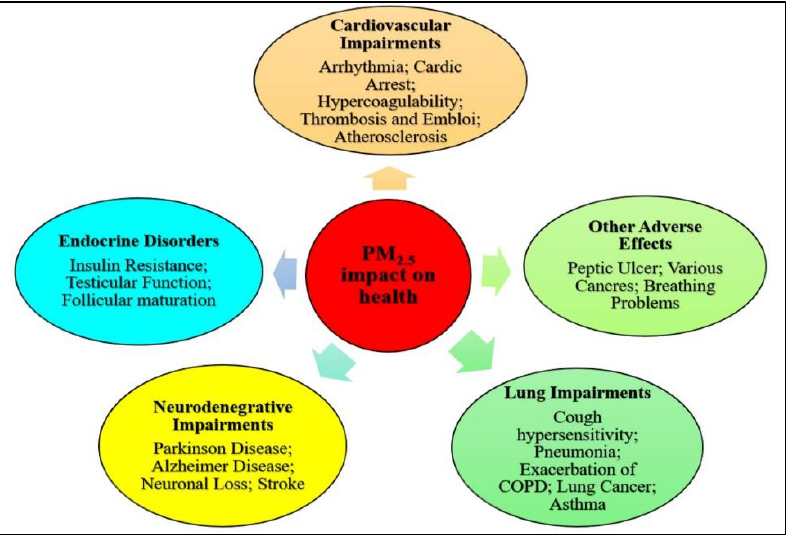
Figure 1. Health impacts of air pollution.